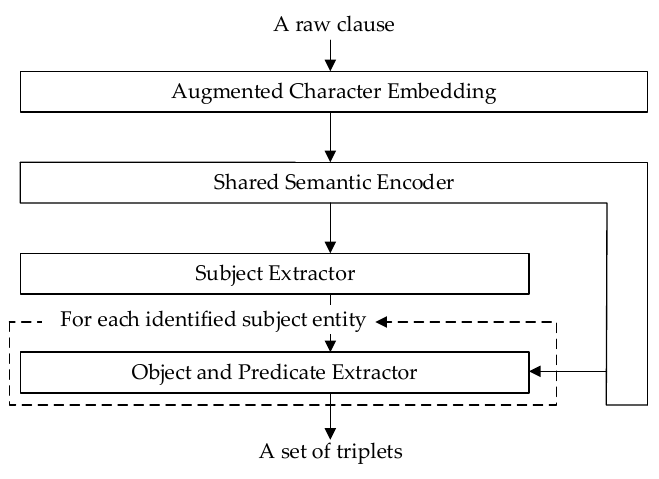
Figure 2. Framework of the joint extraction